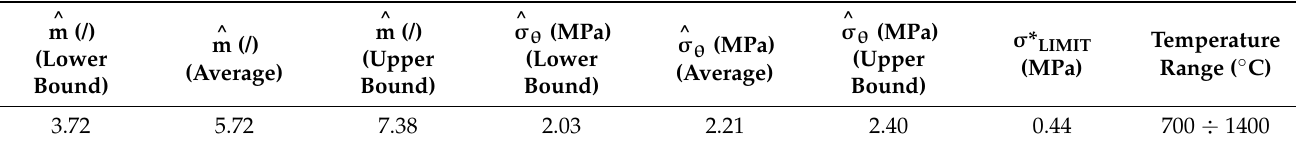
Figure 7. Plot of the Weibull distribution for the 16 tested samples. Table 5 summarizes the Weibull distribution parameters with 90% confidence bounds and the material virtual stress limit, σ * lim . This value was computed from the Weibull distribution, taking a failure probability of 0.01% as a reference, which corresponded to a survival probability of 99.99%. Table 5. The Weibull distribution parameters (with 90% confidence bounds) and the referential stress limit calculated with the VTP approach.